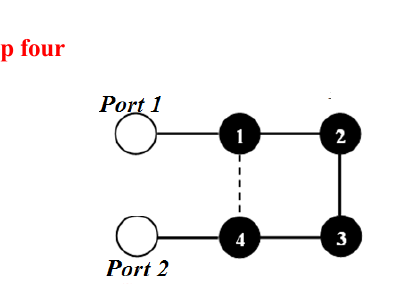
FIGURE 9. Step three: EM response of tuned results (solid lines) and target results (dashed lines).